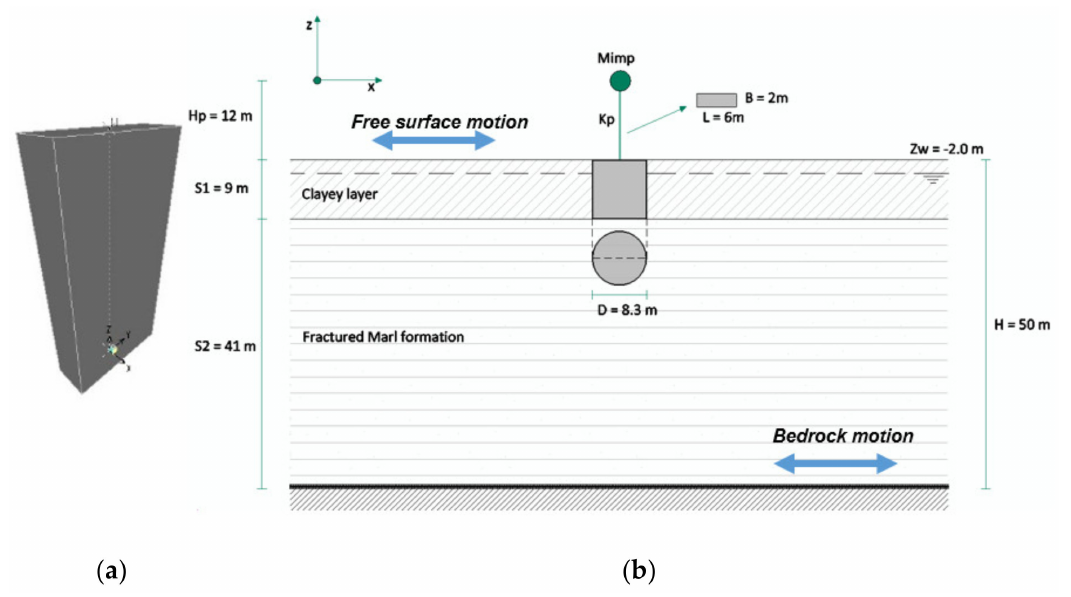
Figure 4. The Figure shows: ( a ) the 3D SAP 2000 model of the beam element fixed to the ground; ( b ) a sketch of the simplified geometry and soil